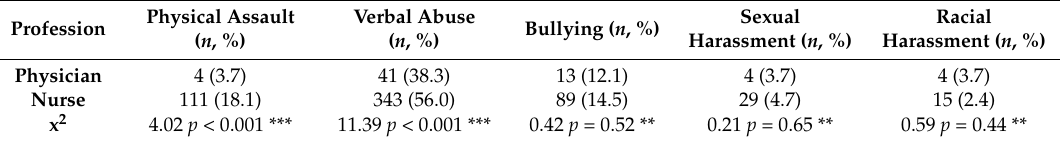
Table 2. Prevalence of physical assault, verbal abuse, bullying, sexual harassment, and racial harassment towards physicians and nurses in Macau ( n =